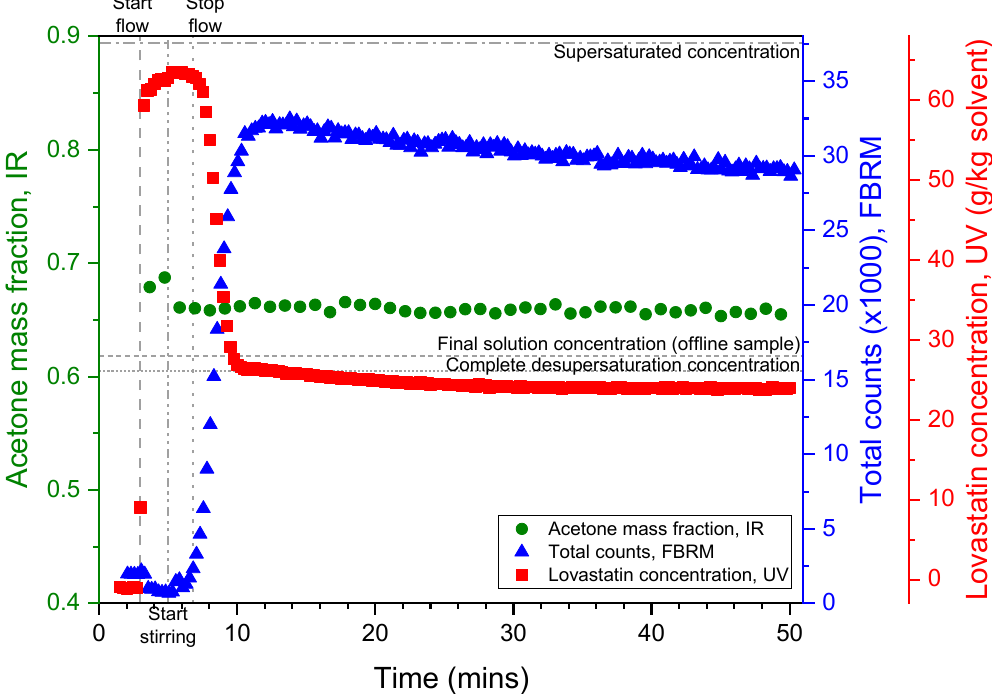
Figure 9. Trends from PAT monitoring of the 1 L STR during Experiment 4: predicted acetone mass fraction by IR, predicted lovastatin concentration by UV, and total counts from FBRM. Experimental events and expected concentrations have been outlined.